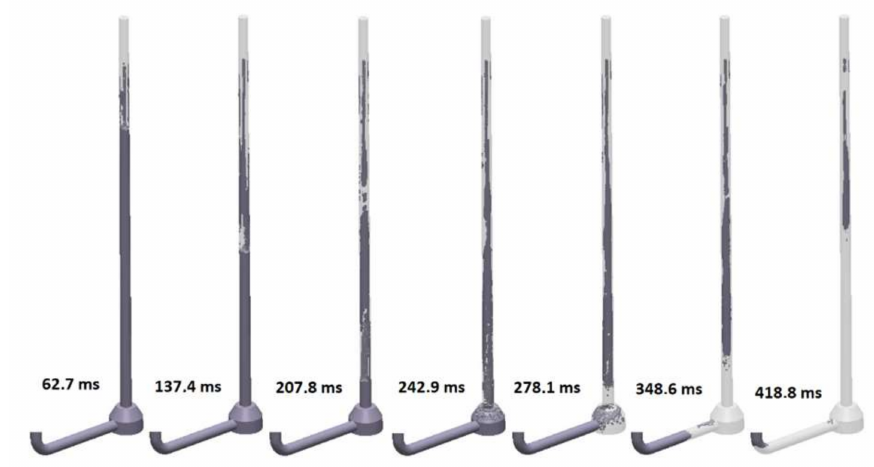
Figure 19. Air evacuation in round, reverse tapered sprue with choke (S s 2),